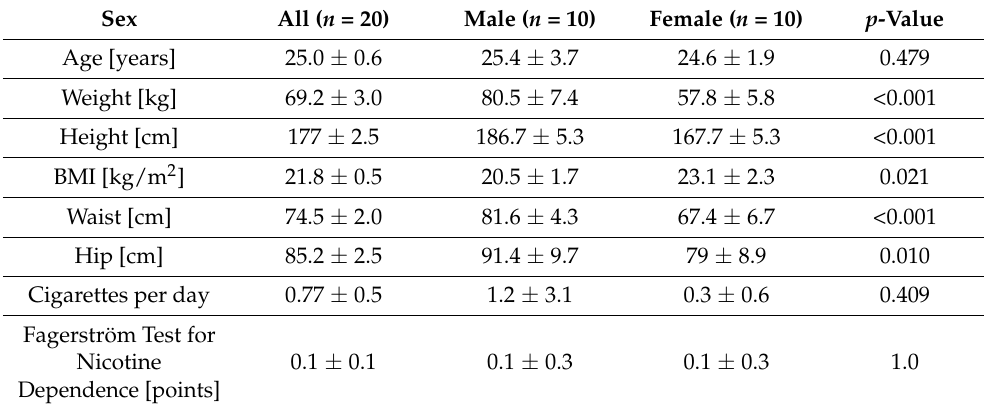
Table 1. Specifies baseline characteristics for all